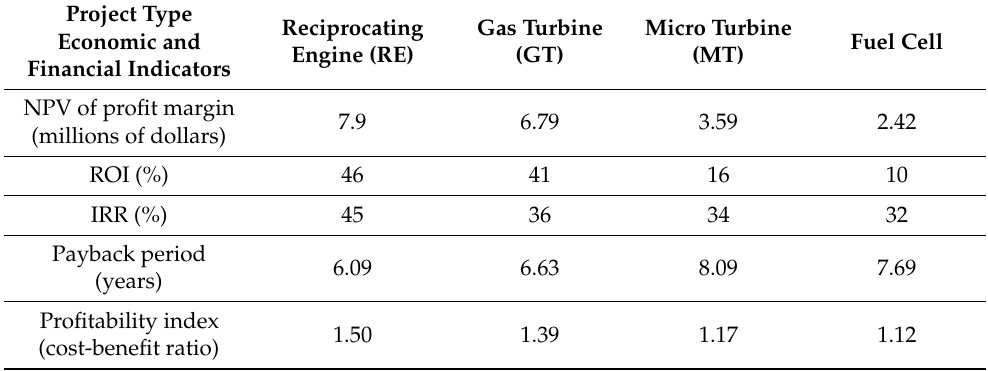
Table 4. Economic and financial analysis of the energy recovery potential project